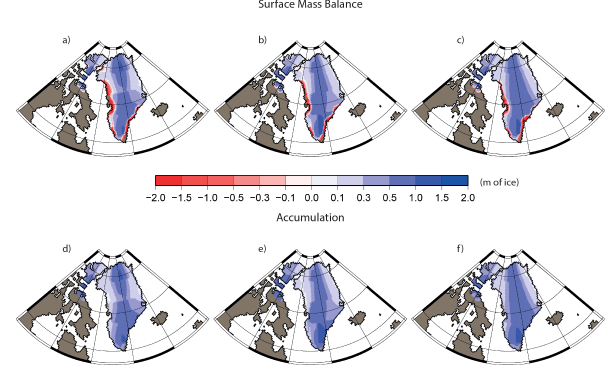
Figure 5. 1000-year averages. First row: mass balance (m): (a) CTRL, (b) CALV and (c) FWFf; 2nd row: accumulation (m): (d) CTRL, (e) CALV and (f) FWFf (non-linear colour